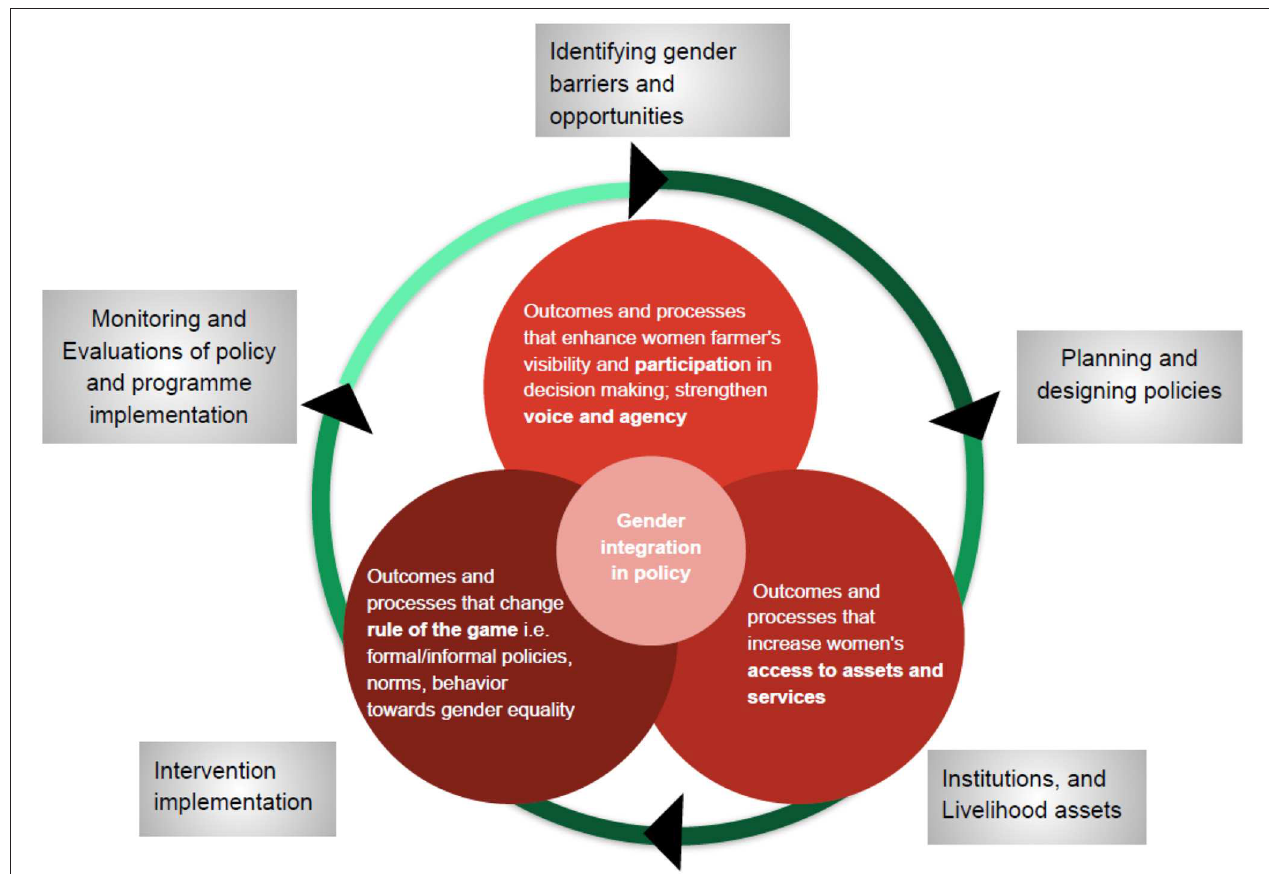
FIGURE 5 | Framework for gender integration in Nepal/s policy process.